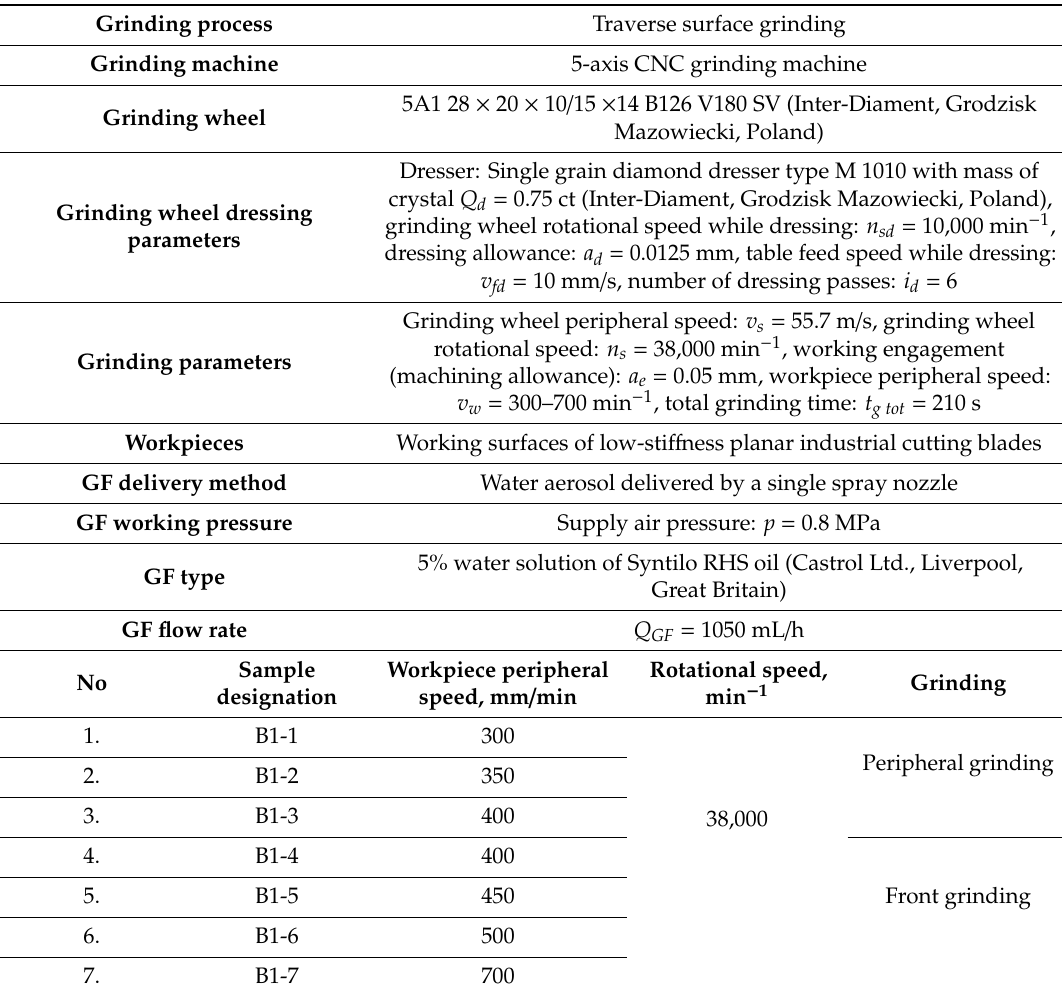
Table 4. General characteristics of machining